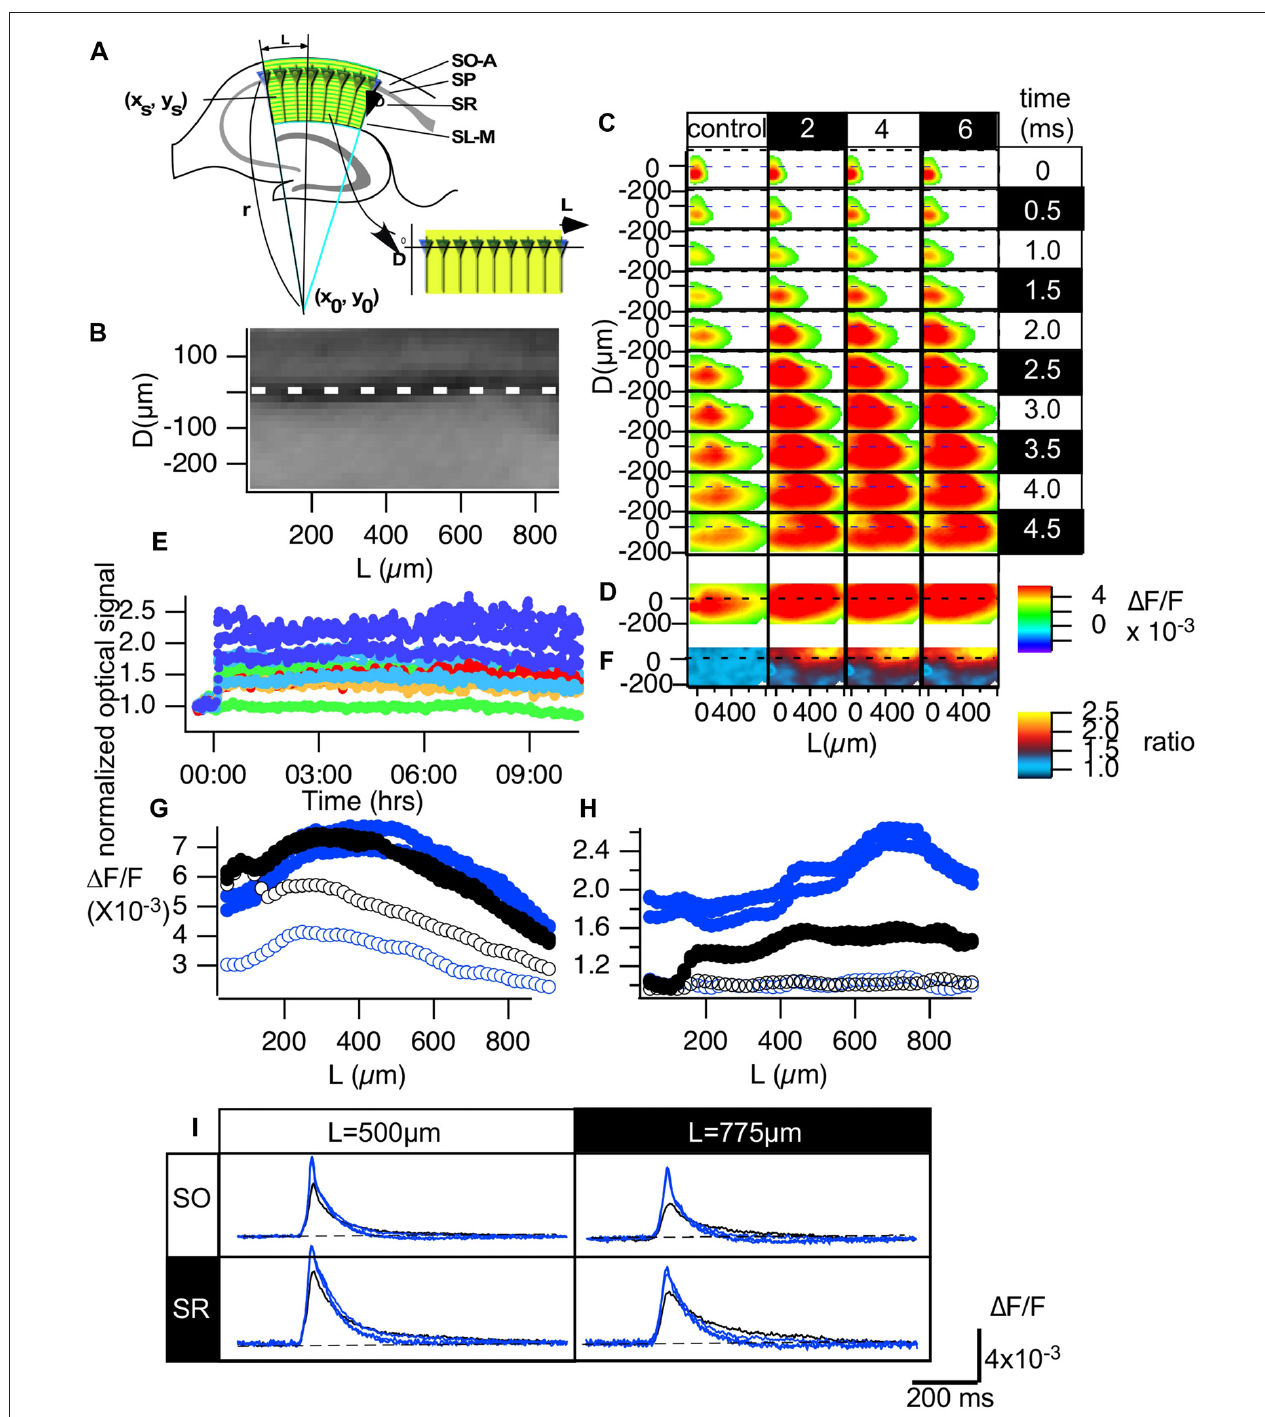
FIGURE 3 | Normalization made it possible to evaluate the optical signals in the CA1 area of hippocampal slices. (A) An illustration of how we converted the hippocampal CA1 area to the distance from the start of the CA1 (L) and the distance from the pyramidale cell layer (D) plane (B) . (C) Representative propagation pattern of the optical signal spread along the CA1 area converted to the D-L plane in each time frame for the control recording and recordings made 2, 4 and 6 h from TBS. (D) The peak value of each pixel in the D-L plane. (E) The time course of the normalized optical signals in pixels of the D-L plane for 10 h. (F) The amplitude of the normalized degree of LTP mapped to the D-L plane at each time point. (G) The line profile of the optical signal along the line at D = − 75 µ m (SO) and D = 150 µ m (SR) at each time point (control, 2, 4 and 6 h). (H) The line profile of the normalized degree of LTP along the same lines. (I) The time course of the optical signal at the representative points ( L = 500 and 775 µ m, respectively) in each line of the SO ( D = − 75 µ m) and the SR ( D = 150 µ m) at each time point.